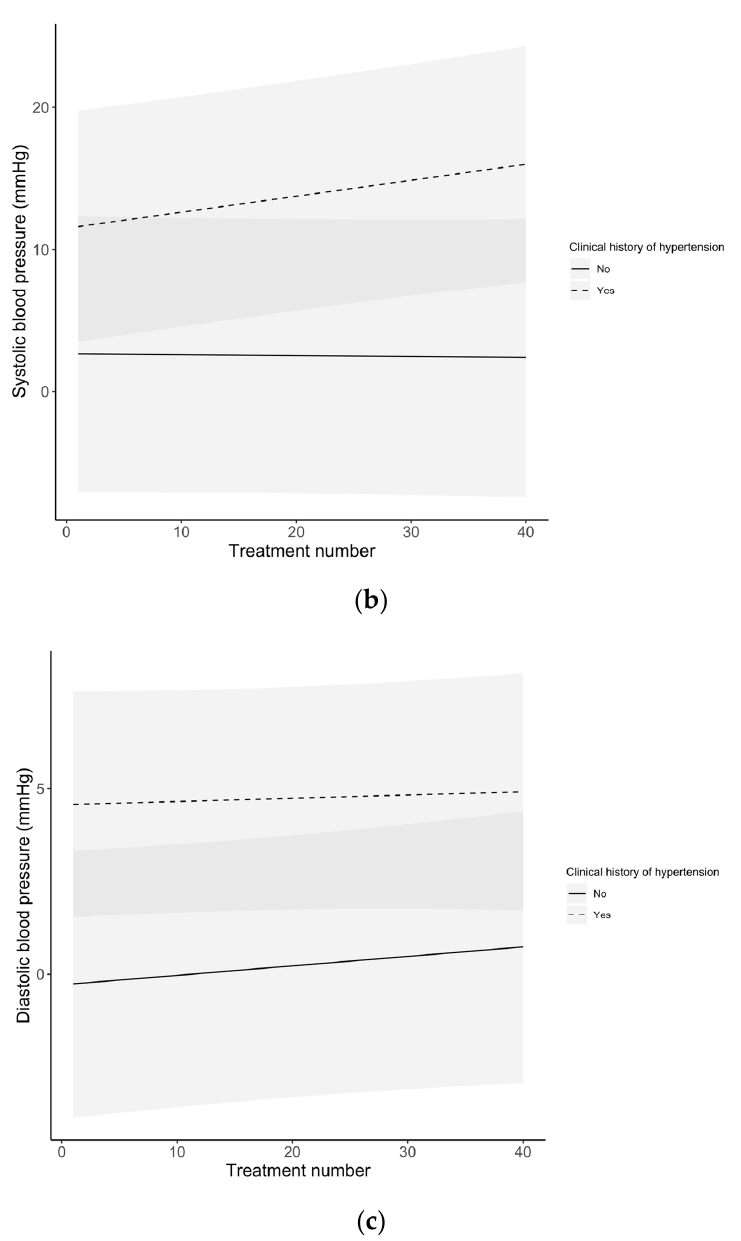
Figure 2. Temporal changes of arterial blood pressure over the total number of HBOT sessions stratified by the history of hypertension. ( a ) Mean arterial pressure; ( b ) systolic arterial pressure; ( c ) diastolic arterial pressure. The shaded area represents the 95% confidence interval.